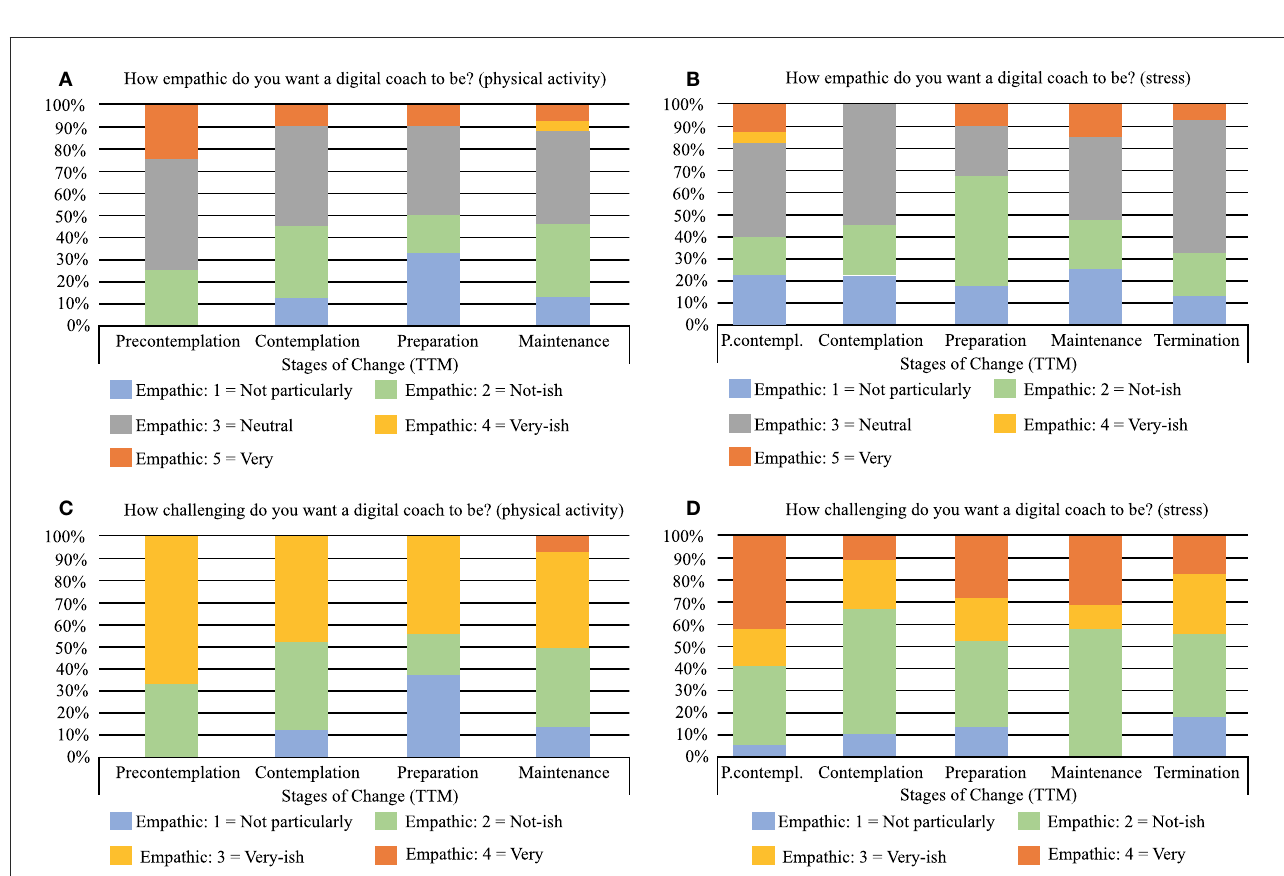
FIGURE5 Preferred behaviors of a digital coach, for the different stages of the TTM, for physical activity (A, C) and stress (B, D) . To be noted: For physical activity, four were in the precontemplation stage, and only one participant was in the termination stage and was therefore omitted in the overview, see Table